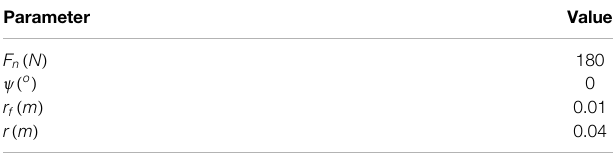
TABLE 1 | Nominal parameter values.